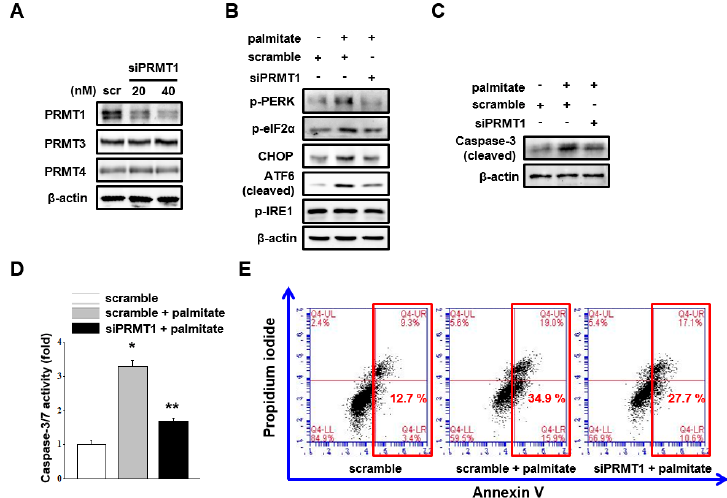
Figure 3. PRMT1 knockdown attenuates palmitate-induced ER stress signaling and mesangial cell apoptosis. ( A ) Mesangial cells were transfected with scramble or PRMT1 siRNA according to the reverse transfection method. After 36 h, cell extracts were subjected to western blot analysis with indicated antibodies. The representative immunoblots were from at least three independent experiments; ( B – E ) mesangial cells were transfected with scramble or PRMT1 siRNA according to the reverse transfection method. After 24 h, cells were treated with 30 μ M palmitate for 24 h; ( B , C ) cell extracts were subjected to western blot analysis with indicated antibodies. Representative immunoblots were from at least four independent experiments; ( D ) caspase 3/7 activity was measured. Data represent the mean ± SEM of three independent experiments, each performed in triplicate. * p < 0.05 vs. scramble, ** p < 0.05 vs. scramble + palmitate; ( E ) annexin V and propidium iodide stainings were analyzed. Red frame indicates the sum of early apoptotic cells and late apoptotic cells. The representative images were from at least three independent experiments.